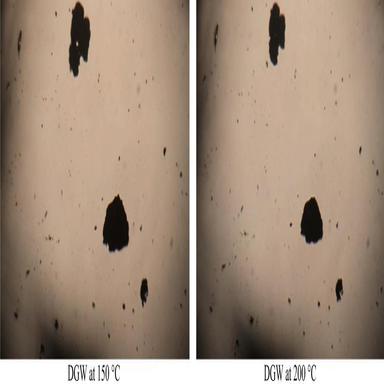
Images captured under the optical microscope: a) start of heating and b) start of the melting phase.